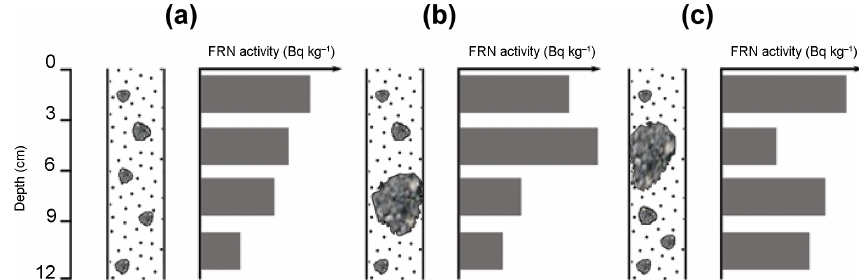
Figure 4. Possible influence of stones on the FRN depth